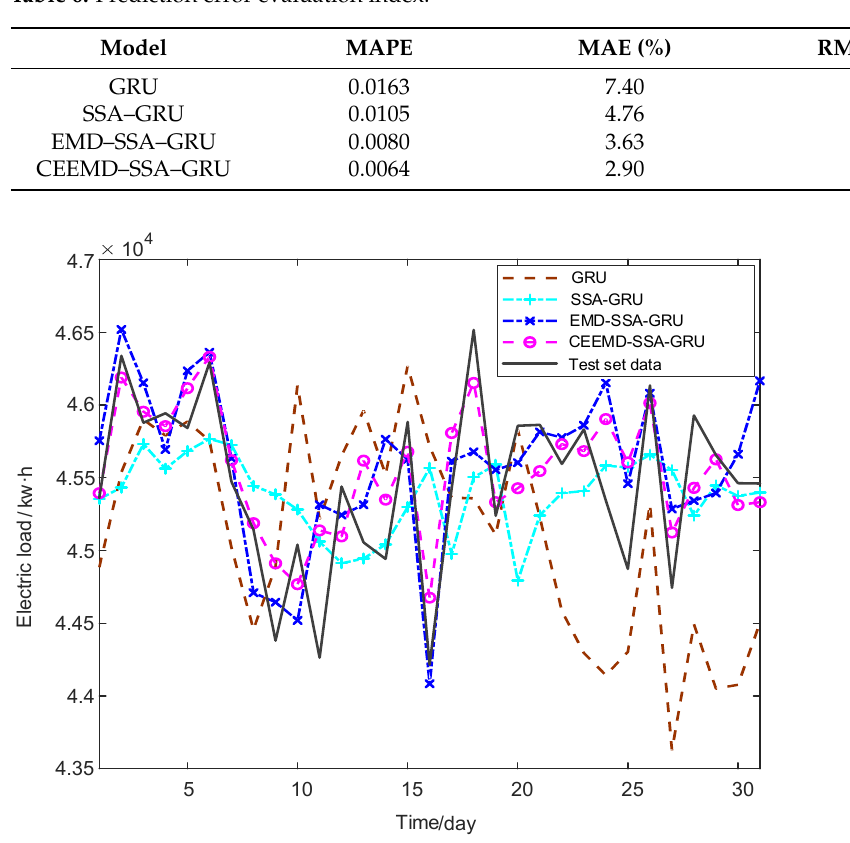
Figure 17. Comparison of prediction errors of four models. According to the calculation of error evaluation index formula, the comparison of various error evaluation indexes is shown in Table 6.